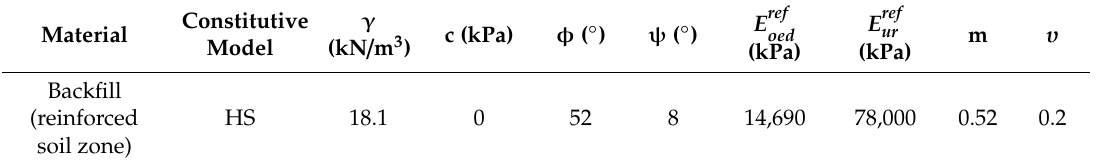
Table 1. Input parameters of backfill (reinforced soil zone) for validation analysis.